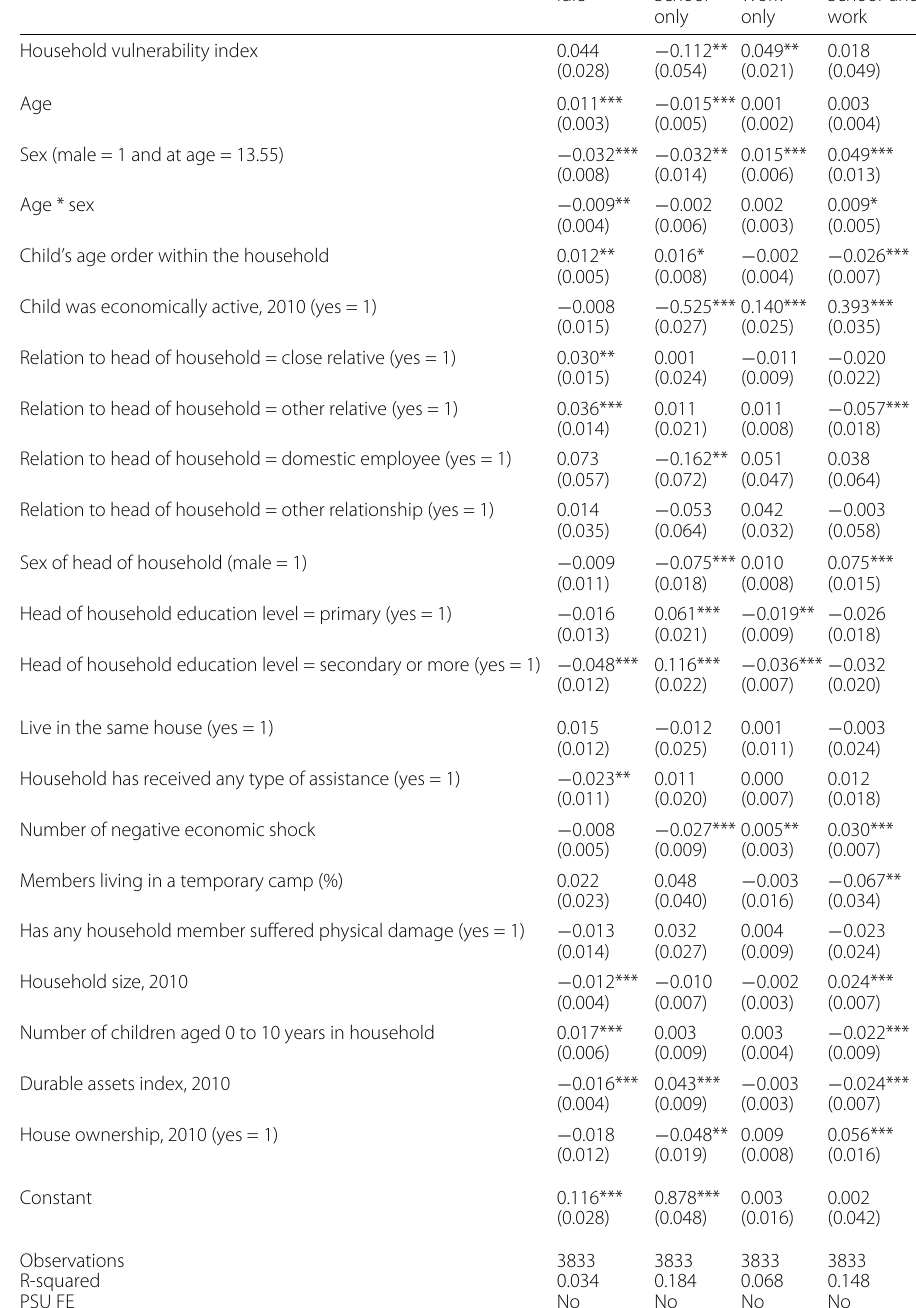
Table 9 OLS model without FE, school/work decision